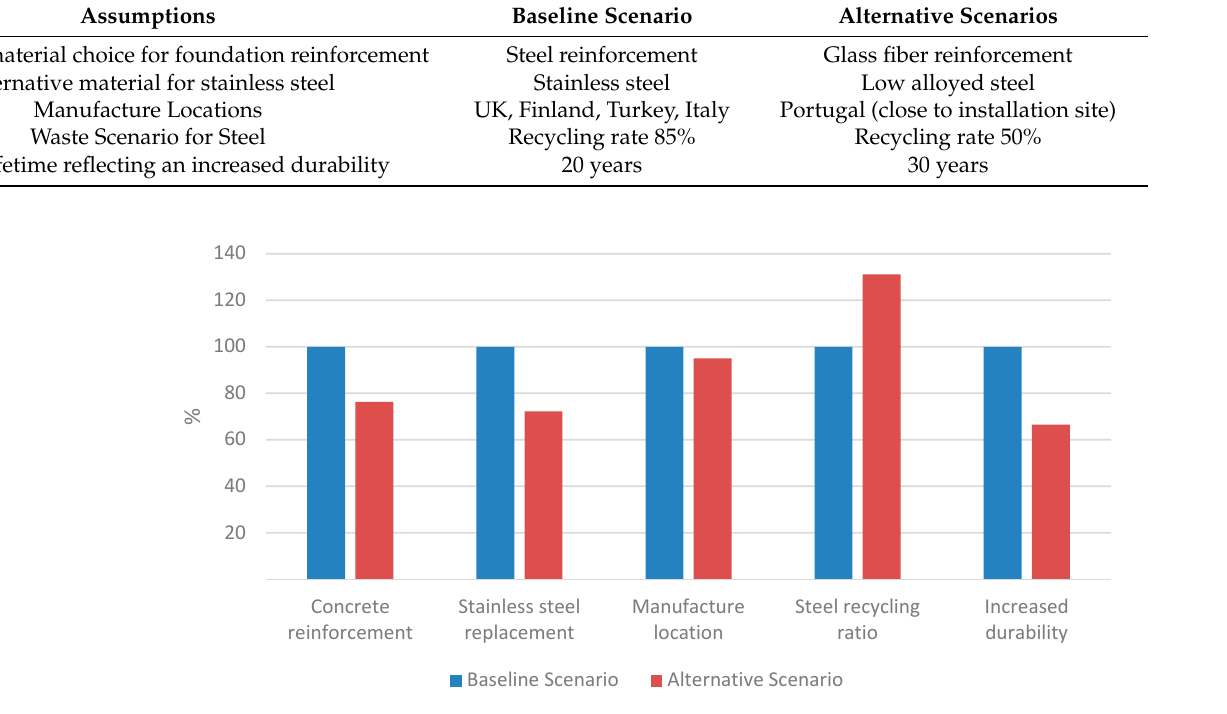
Figure 9. Alternative scenarios (results are normalized compared to the baseline scenario).